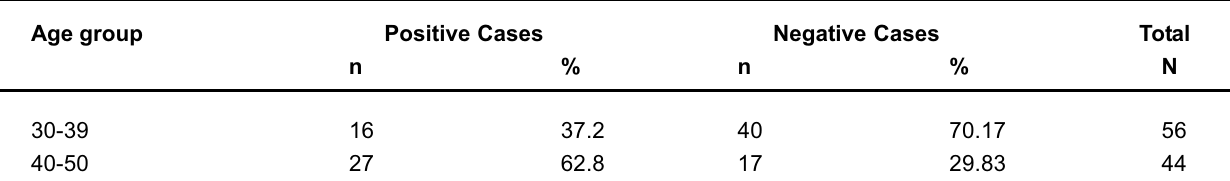
Fisher’s exact test